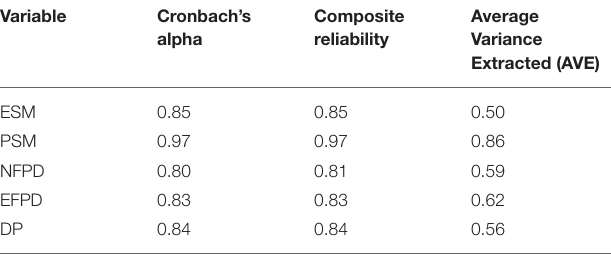
TABLE 2 | Results of confirmatory factor analysis.